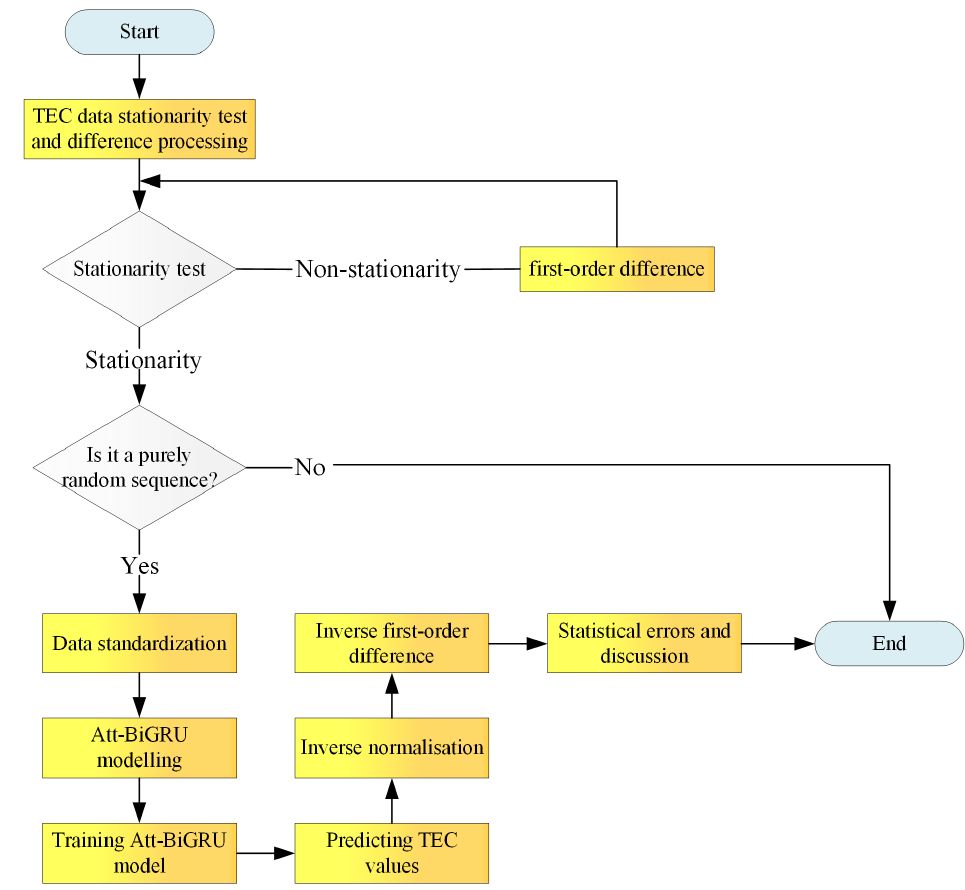
Figure 4. Whole experimental process in this paper.